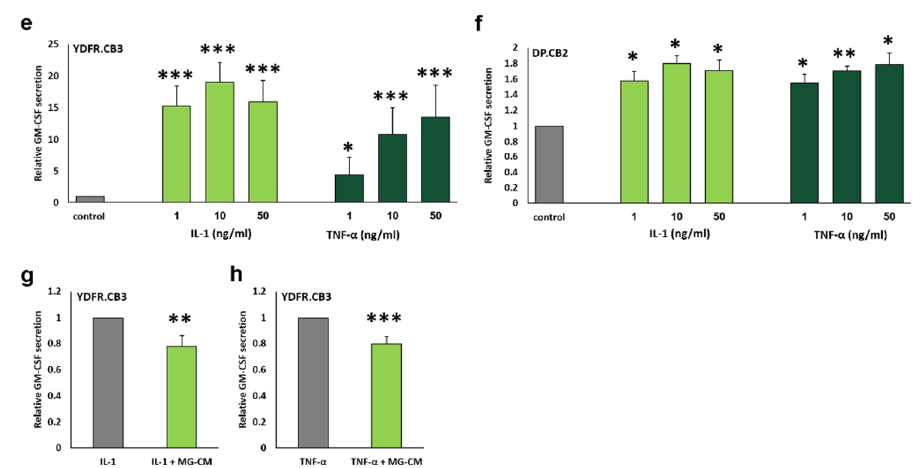
Figure 2. Regulation of melanoma-derived GM-CSF by brain microenvironment-secreted factors. ( a-h ) Extracellular levels of GM-CSF were estimated by ELISA analysis. (a,b) 5x10 5 YDFR.C, YDFR.CB3 ( a ), DP.C and DP.CB2 ( b ) cells were cultured for 24 h. The bars represent GM-CSF levels in 15-fold concentrated supernatants (pg/mL). ( c , d ) 5x10 5 YDFR.CB3 ( c ) or DP.CB2 ( d ) cells were treated with microglia-CM (MG-CM), brain endothelial cell-conditioned medium (BEC-CM) or astrocyte-conditioned medium (HA-CM). After 4 h, cells were cultured in starvation medium for 20 h. Treatment with starvation medium was used as control (medium). ( e , f ) 5x10 5 YDFR.CB3 ( e ) and DP.CB2 ( f ) cells were simulated with rhIL-1α (1, 10 and 50 ng/mL) or rhTNF-α (1, 10 and 50 ng/mL) for 24 h. Unstimulated cells were used as control. Note: The scale of the two graphs is different. (g, h) 5x10 5 YDFR.CB3 cells were stimulated with either rhIL-1α ( g ) or rhTNF-α ( h ) (10 ng/mL) diluted in MG-CM (rhIL1 + MG-CM, rhTNF-α + MG-CM) or in starvation medium as control (rhIL1-1 α, rhTNF-α) for 4 h, then cultured in starvation medium for 20 h. For each of the experiments, the bars represent the relative GM-CSF levels normalized to control. All graphs represent an average of at least three independent experiments ± SD. * p < 0.05, ** p < 0.01, *** p < 0.001.